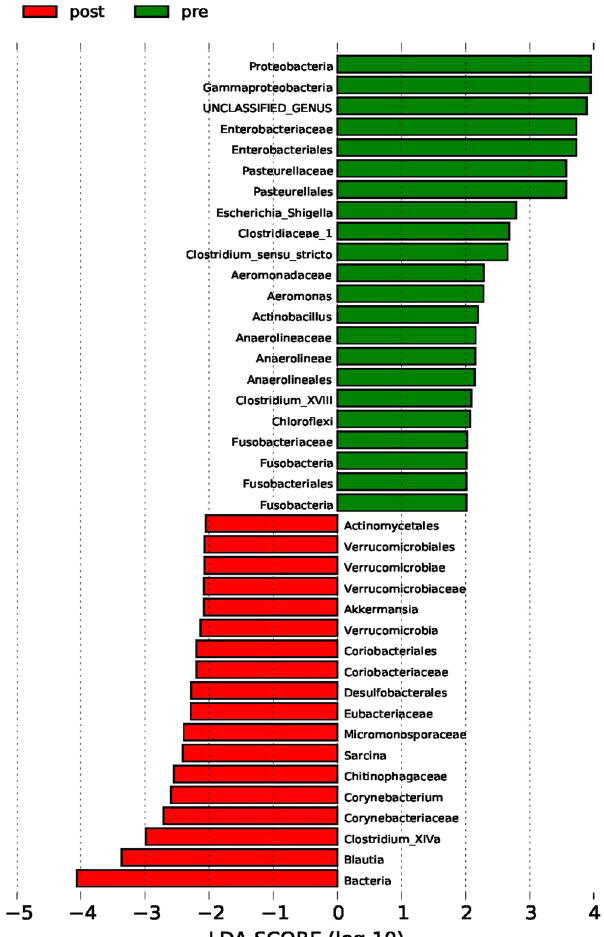
Figure 3. LEfSe analysis of differential species abundance between the pre-LT and post-LT groups was performed. The LDA score is used as the abscissa, and higher scores indicate a greater difference. The red and green horizontal bars represent the species enrichment in the post-LT and pre-LT groups,